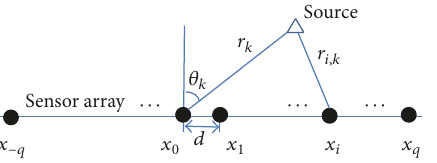
Figure 1: A near-field source impinges onto a ULA with 𝑀 = 2𝑞+1